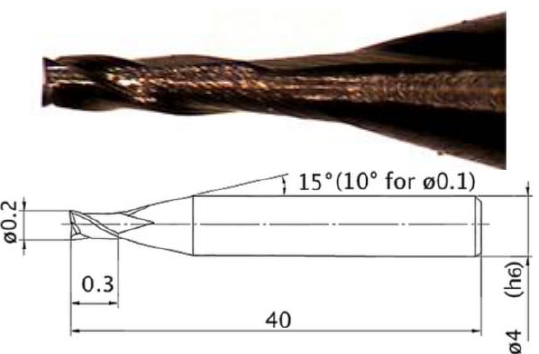
Figure 3. Mitsubishi MS2SSD0020 mill.